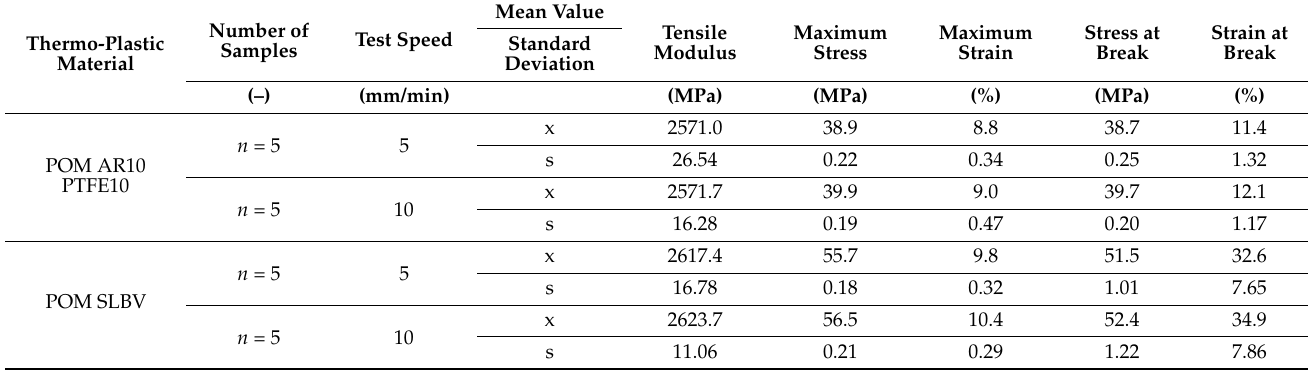
Table 4. Mechanical properties of the POM copolymers determined in a tensile test, according to DIN EN ISO 527-1 type 1A. Number of Thermo-Plastic Material